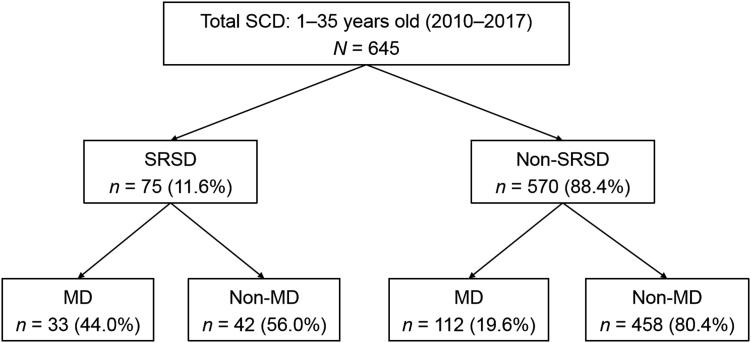
Flowchart of data collection. SCD: sudden cardiac death; SRSD: sports-related sudden death; non-SRSD: non-sports related sudden death; MD: myocardial diseases; non-MD: non myocardial diseases.